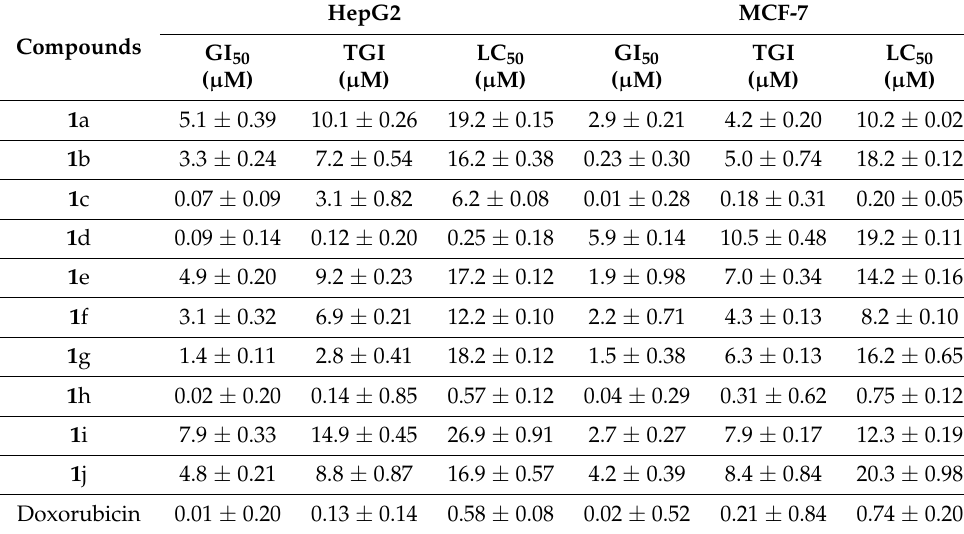
Table 1. Cytotoxic effect of compounds ( µ M) 1 a– 1